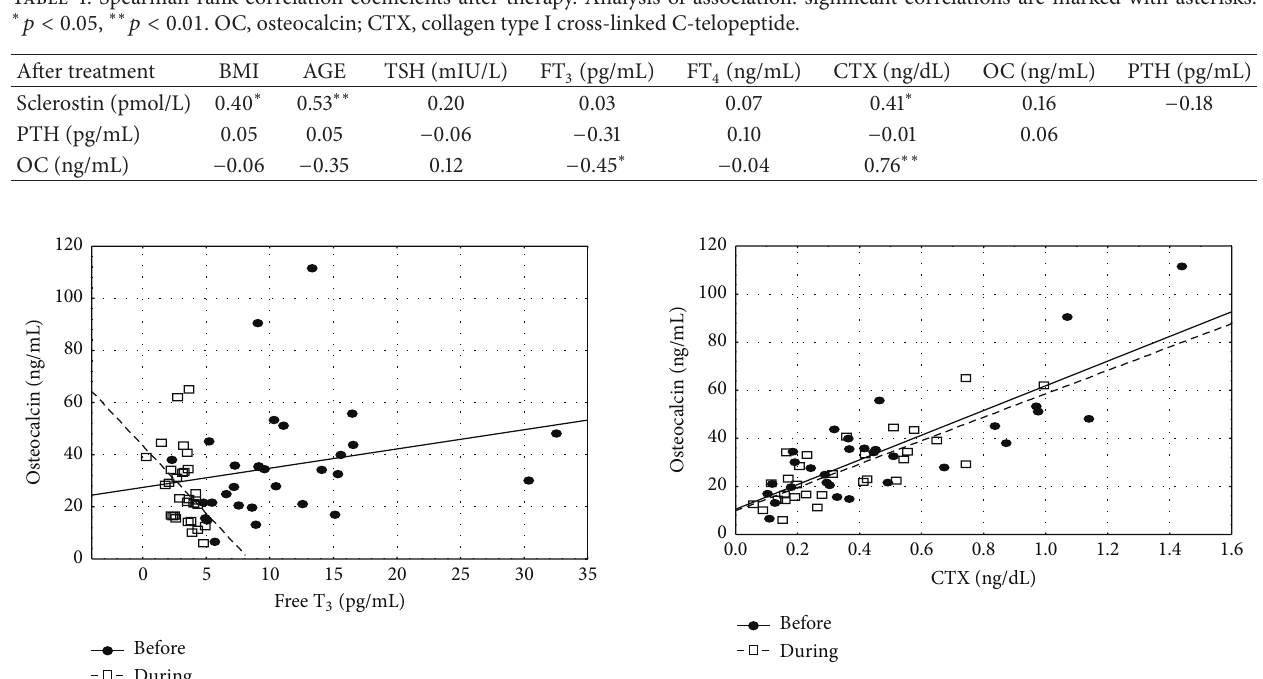
Figure 3: Scatterplot for osteocalcin and CTX, before and during hyperthyroidism treatment ( 𝑟 𝑠 = 0.76 , both before and after treatment, 𝑝 < 0.01